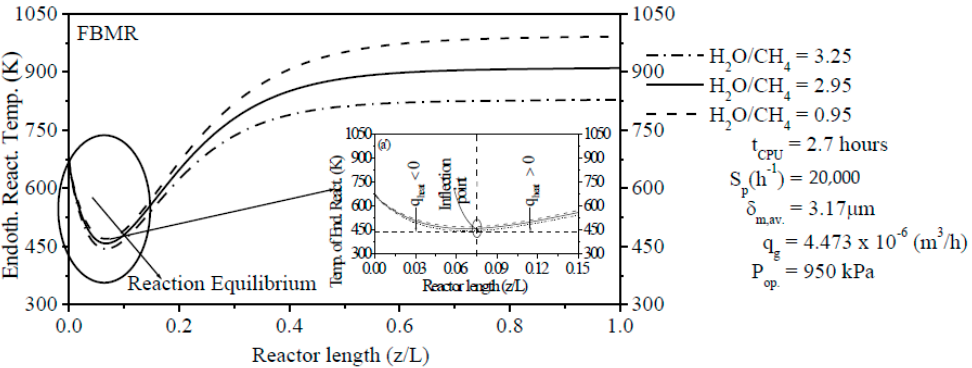
Figure 4. Effect of the H 2 O/CH 4 ratio on the ERT along the reaction zone length from PBMR on Ni/ γ - Al 2 O 3 .